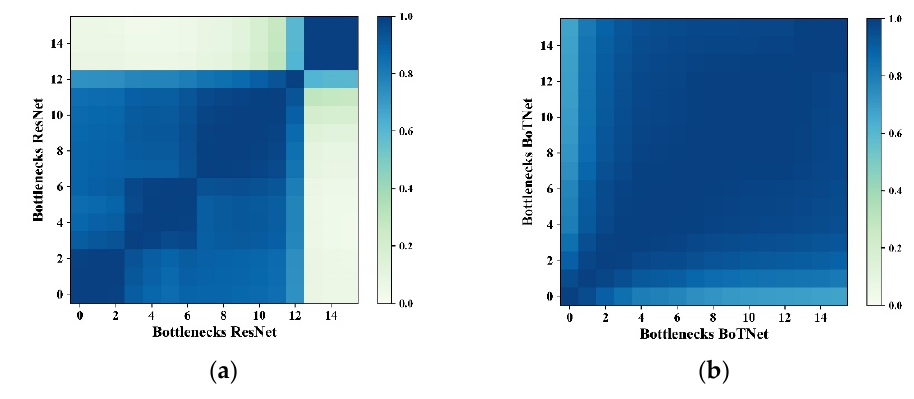
Figure 13. Feature map similarity. ( a ) ResNet and ( b ) BoTNet.